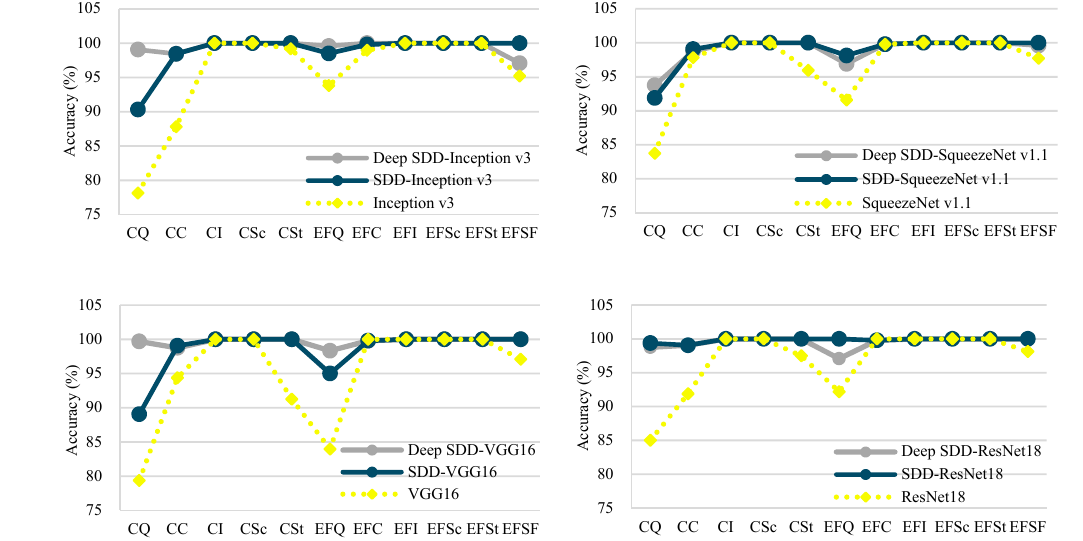
Figure 8. Comparison of validation accuracy for different models with different